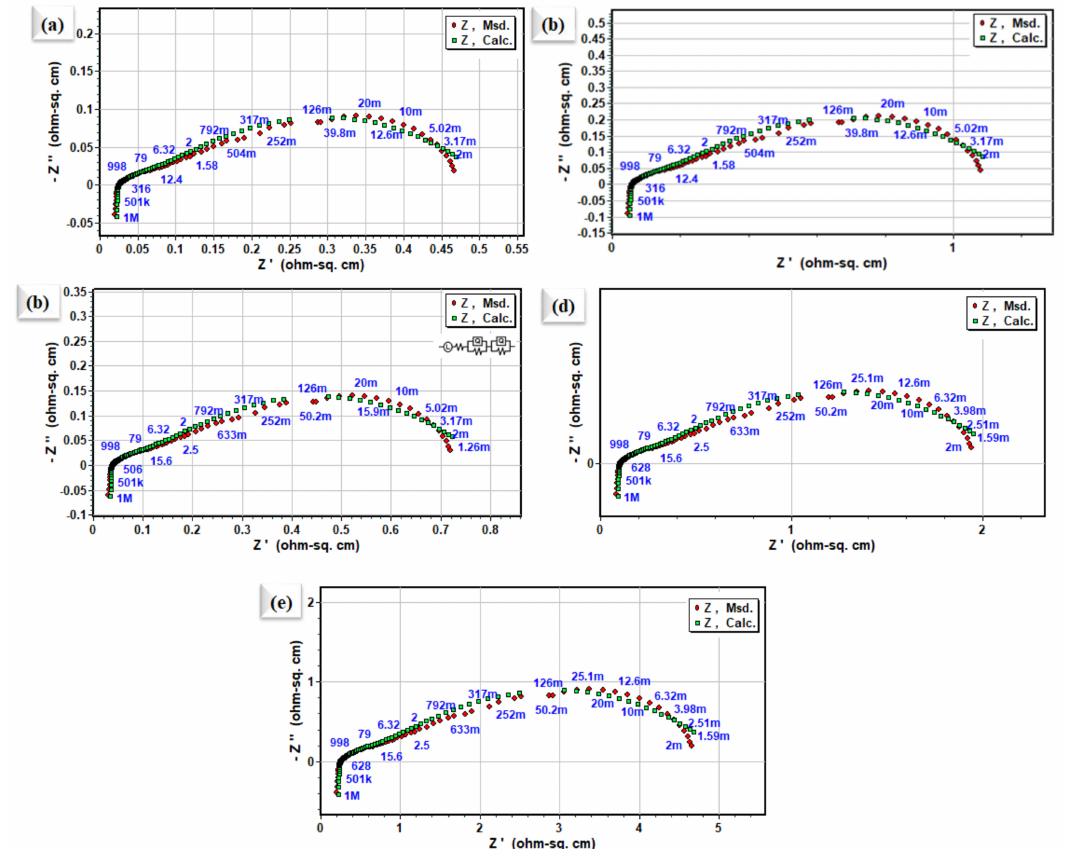
Figure 5. Nyquist plot of impedance spectra for symmetrical electrode cell based on La 0.2 Sr 0.8 Co 0.8 Ce 0.2 O 3 − δ embedded on porous Ni-foam cathode over GDC electrolyte ( a – e ) at 550 ◦ C, 500 ◦ C, 450 ◦ C, 425 ◦ C, and 400 ◦ C,